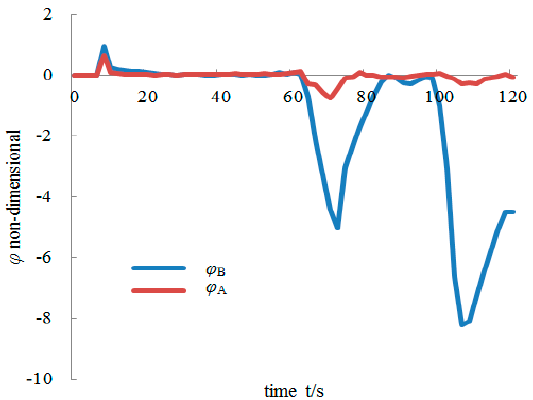
Figure 11. The dynamic correction fact before and after the correction.